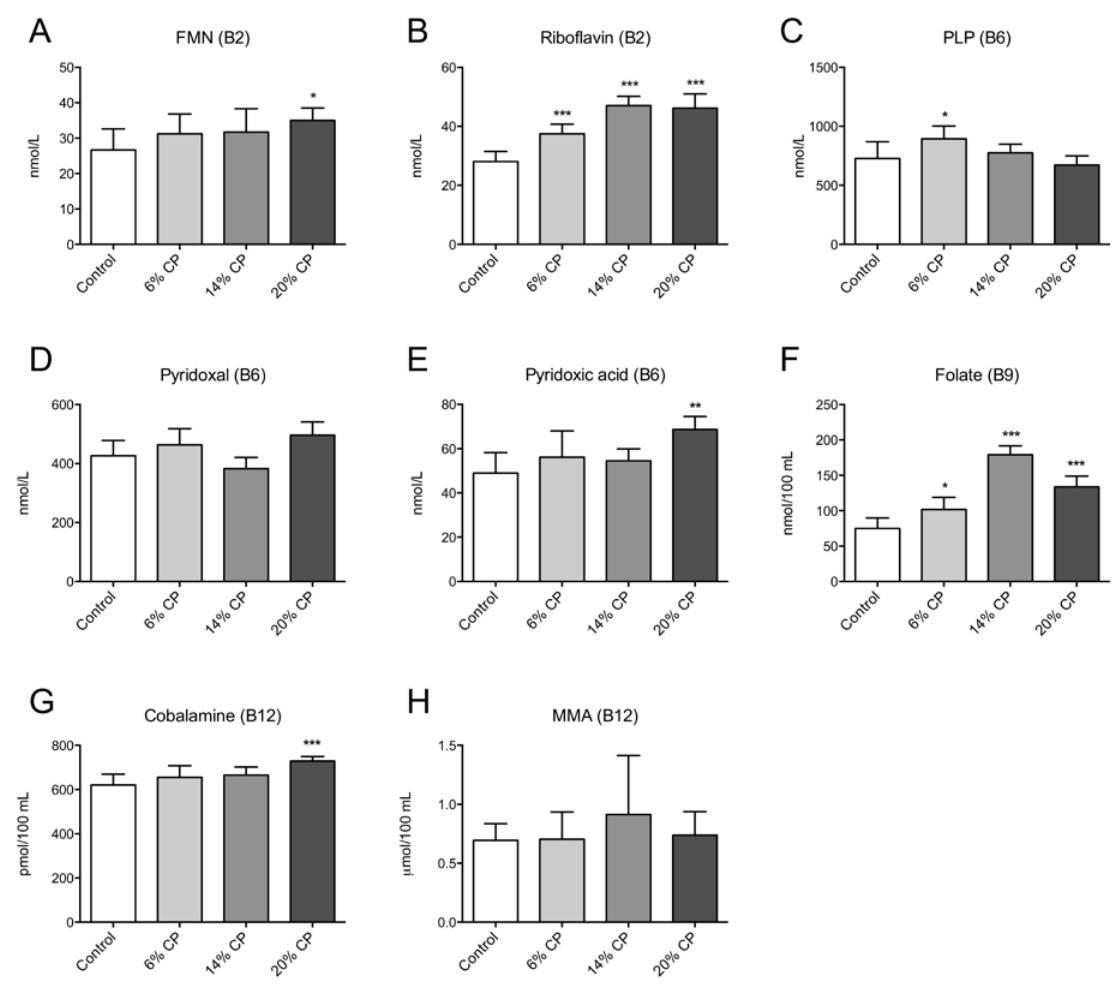
Figure 4. Plasma concentrations of markers of B-vitamin status. Rats were fed a 20% (w/w) casein control diet, or a diet containing 6%, 14% or 20% chicken protein (CP) for 4 weeks. Flavin mononucleotide (FMN, A ), riboflavin ( B ), pyridoxal phosphate (PLP) ( C ), pyridoxal ( D ), pyridoxic acid ( E ), folate ( F ), cobalamin ( G ), and methylmalonic acid (MMA, H ), were measured in fasting plasma samples. Values shown are means ± standard deviation ( n =